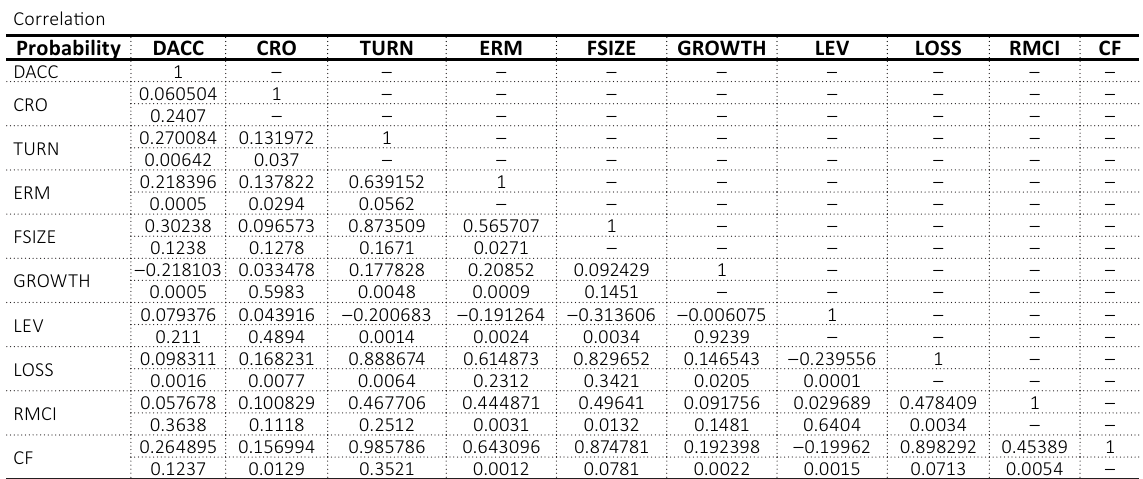
Table 2. Pearson correlation of pre-ERM period (2007–2011)